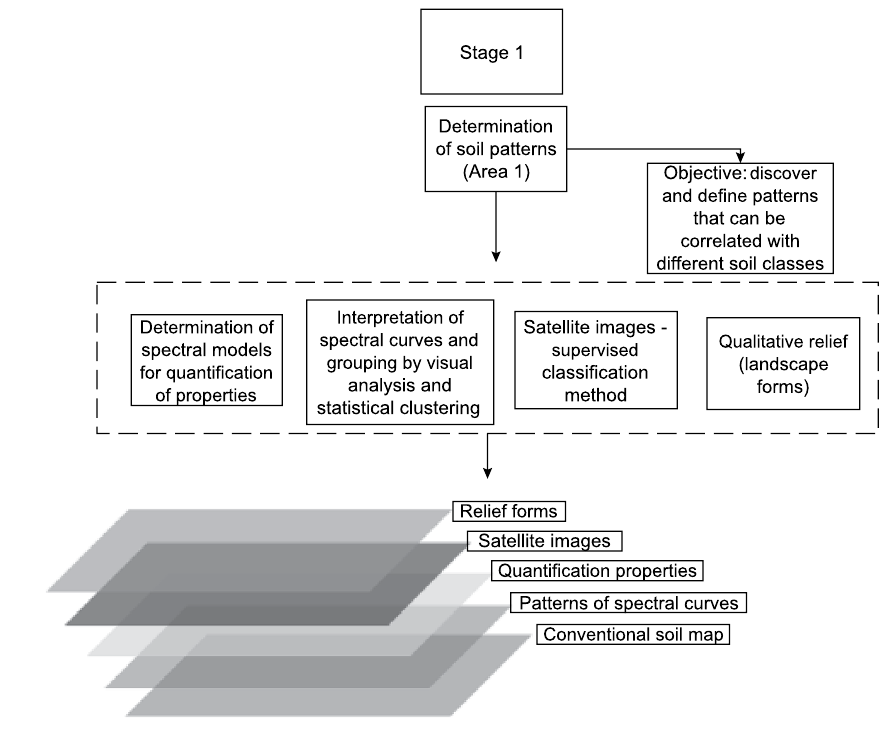
figure 1. flowchart of activities in stage